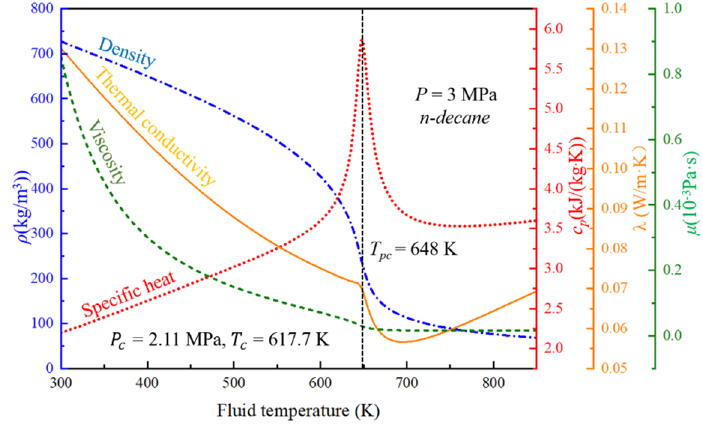
Figure 1. Thermo-physical properties of n -decane at a pressure of 3 MPa from NIST database (Pc, critical pressure; T c , critical temperature).